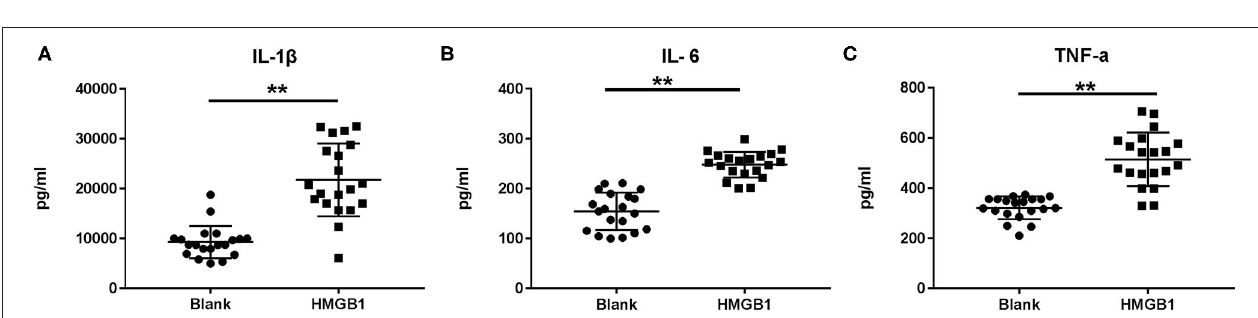
FIGURE 4 | Cytokine production following stimulation of HMGB1 measured by ELISA. When stimulated with HMGB1, the mDCs from systemic lupus erythematosus (SLE) patients produced significantly more IL-1 β (A) , IL-6 (B) , and TNF- α (C) than the Blank. Data are presented as the median and interquartile range (IL-1 β : 21745 ± 1632.45pg/ml vs. 9282.6 ± 723.68 pg/ml, t = 6.979, P = 0.000; IL-6: 248.01 ± 5.81 pg/ml vs. 154.41 ± 8.39 pg/ml, t = 9.167, P = 0.000; TNF- α : 514.41 ± 23.90 pg/ml vs. 321.78 ± 10.09 pg/ml, t = 7.423, P = 0.000) ** p < 0.001. IL, interleukin; TNF, tumor necrosis